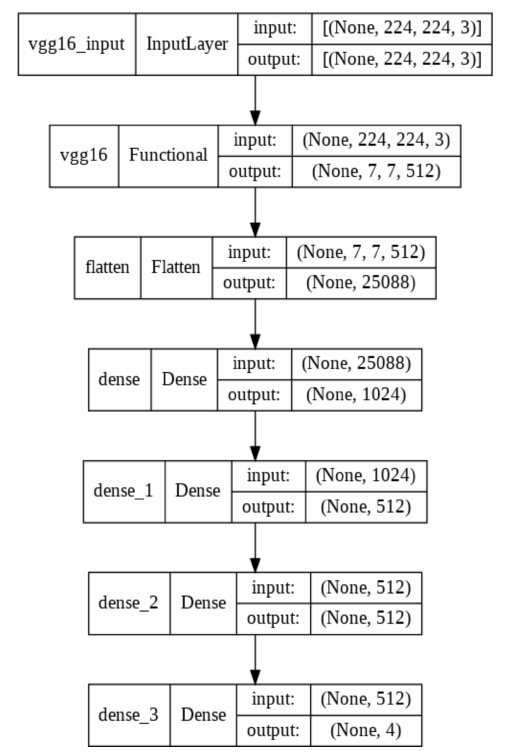
Figure 3. VGG16 architecture for transfer